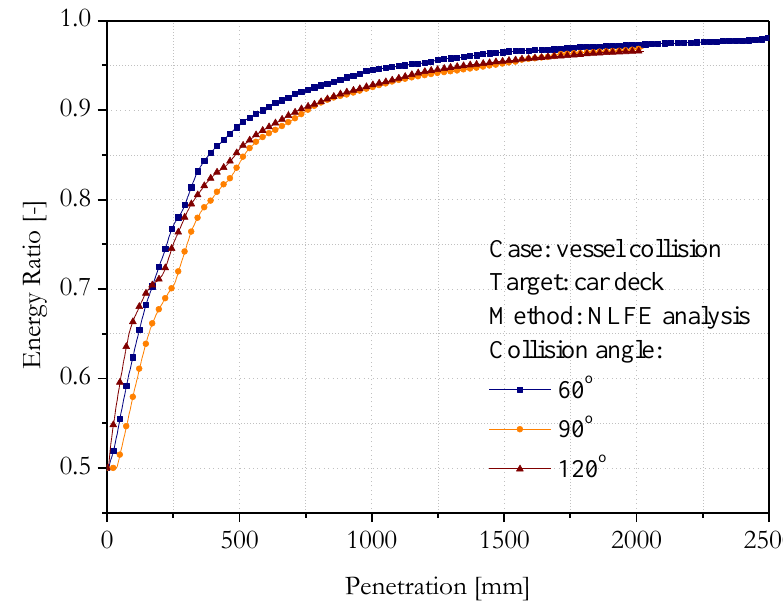
Figure 6. Ratio of the internal energy to the kinetic energy during collisions.